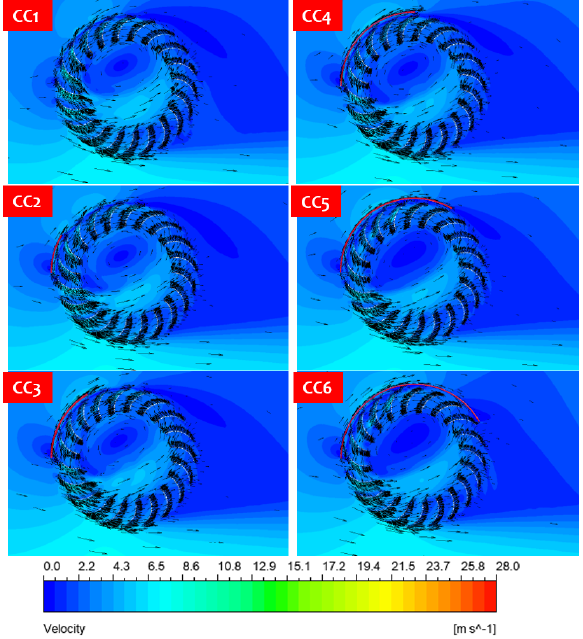
Figure 23. Velocity contours and vectors for Car Cases in the rotor zone taken at (cid:1872) = 5 (cid:1871) .